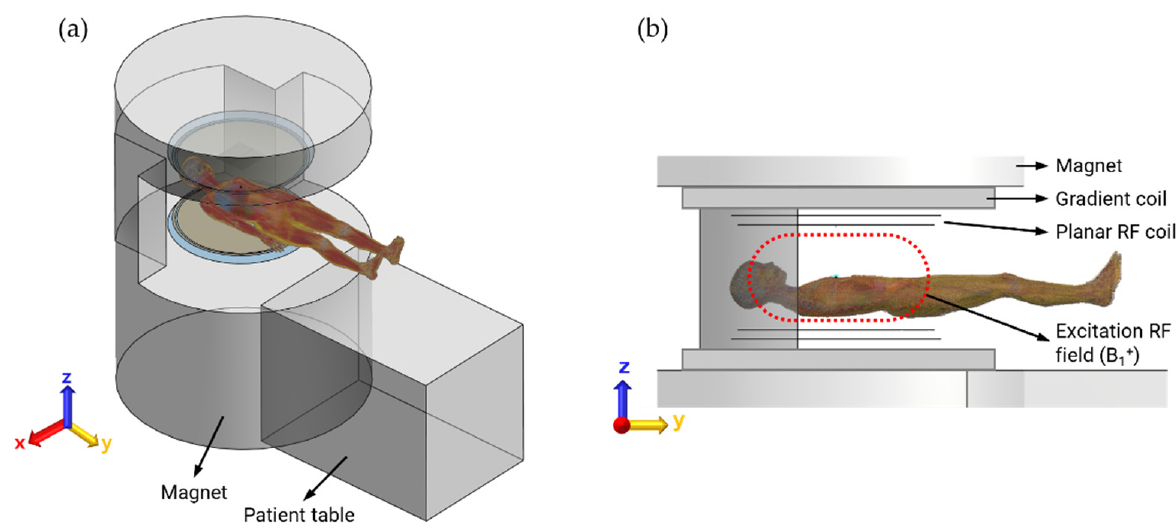
Figure 1. ( a ) View of an open MRI used in this study; ( b ) Top and bottom symmetrically placed magnet, gradient coil, and RF coil in z-direction. Dashed red line indicates the area of transmit RF field (B 1+ ) that is induced by RF coils.